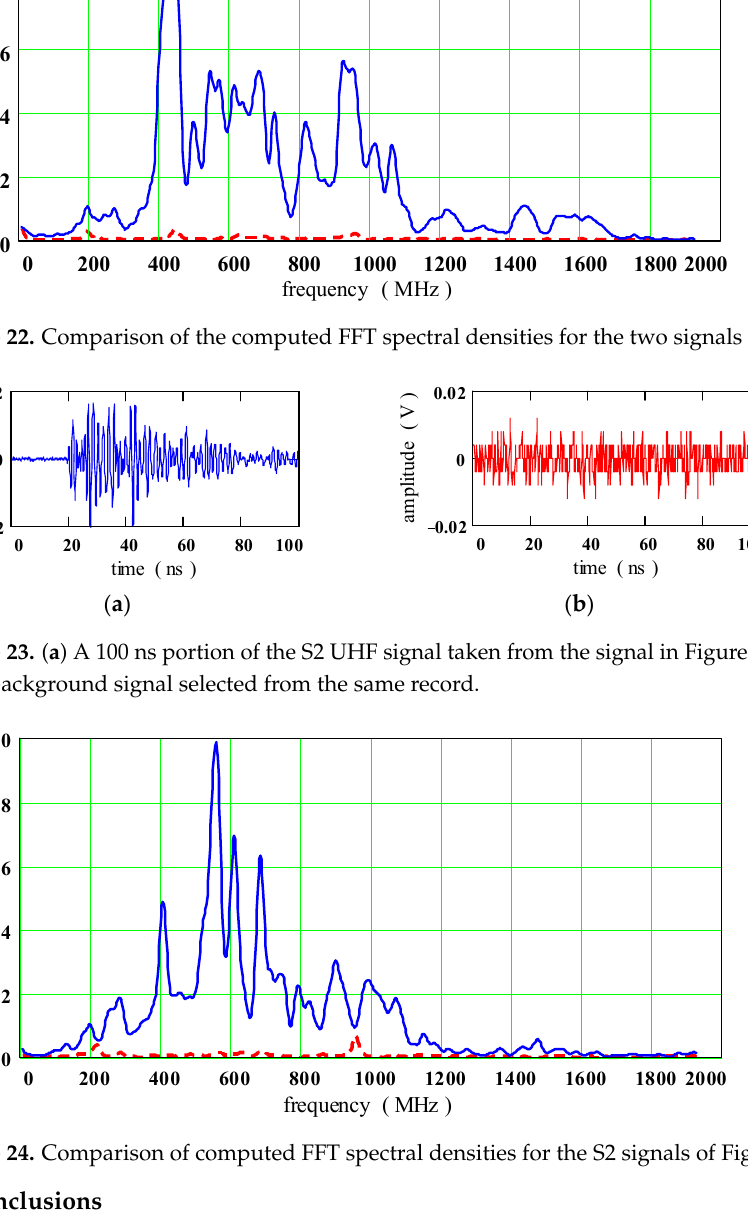
Figure 24. Comparison of computed FFT spectral densities for the S2 signals of Figure 23.